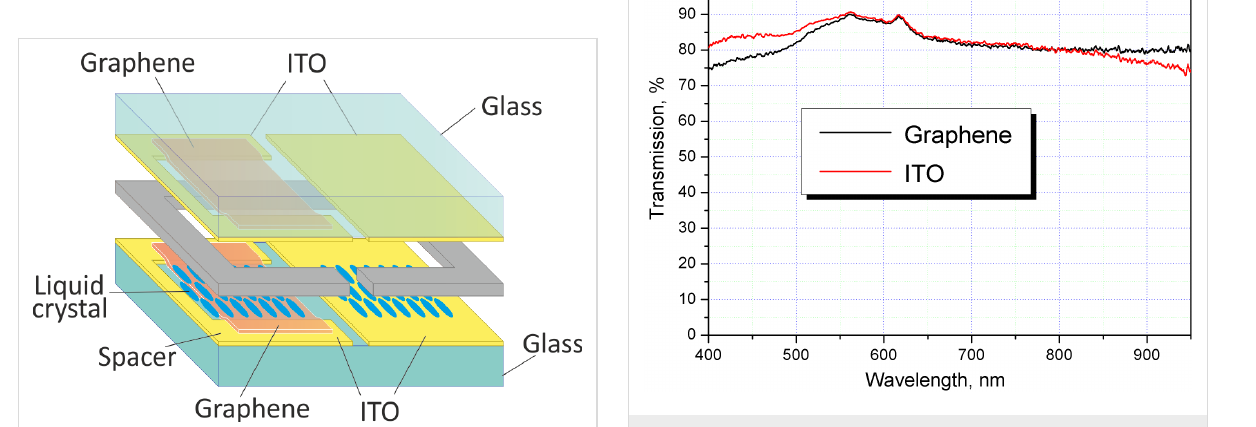
Figure 3: The transmission spectra of graphene and indium tin oxide sections of the hybrid liquid crystal cell.